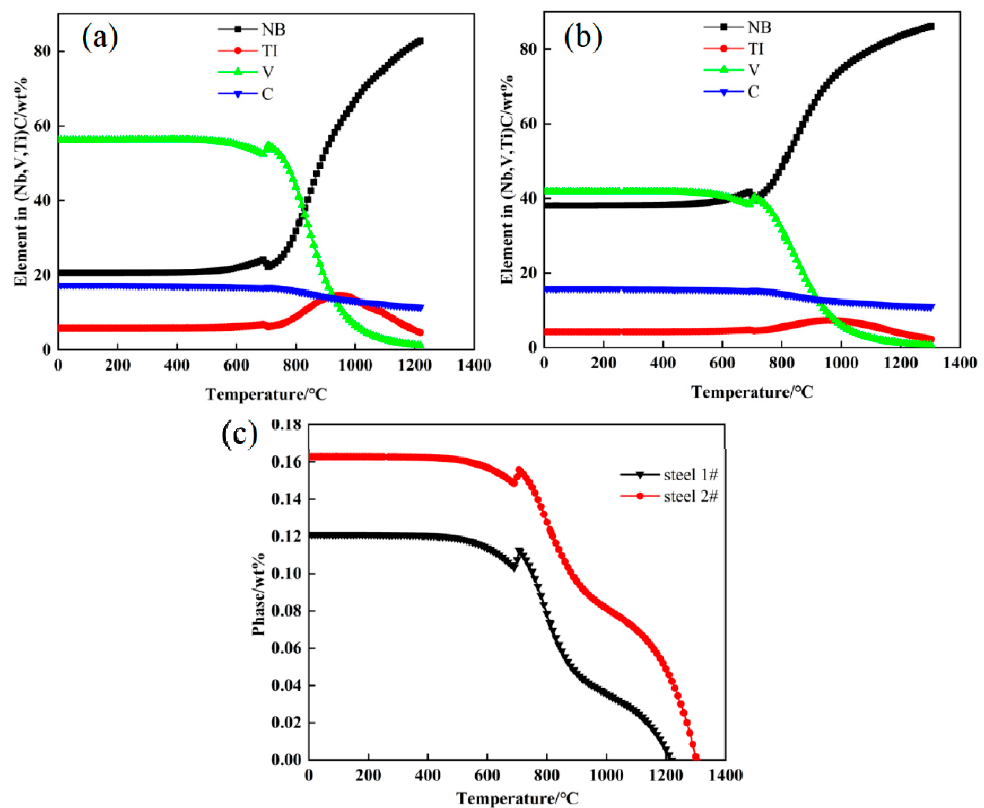
Figure 4. Thermodynamic calculations of precipitation processes using JMatPro software: different elements dissolved in (Nb, V, Ti) C of ( a ) steel 1#, and ( b ) steel 2#; ( c ) precipitation of (Nb, V, Ti)C compound.